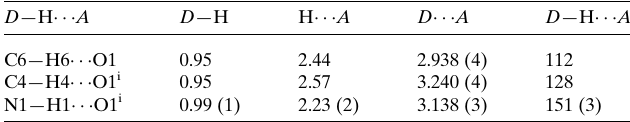
Table 2 Hydrogen-bond geometry (A˚ , (cid:2) ) for MOP .